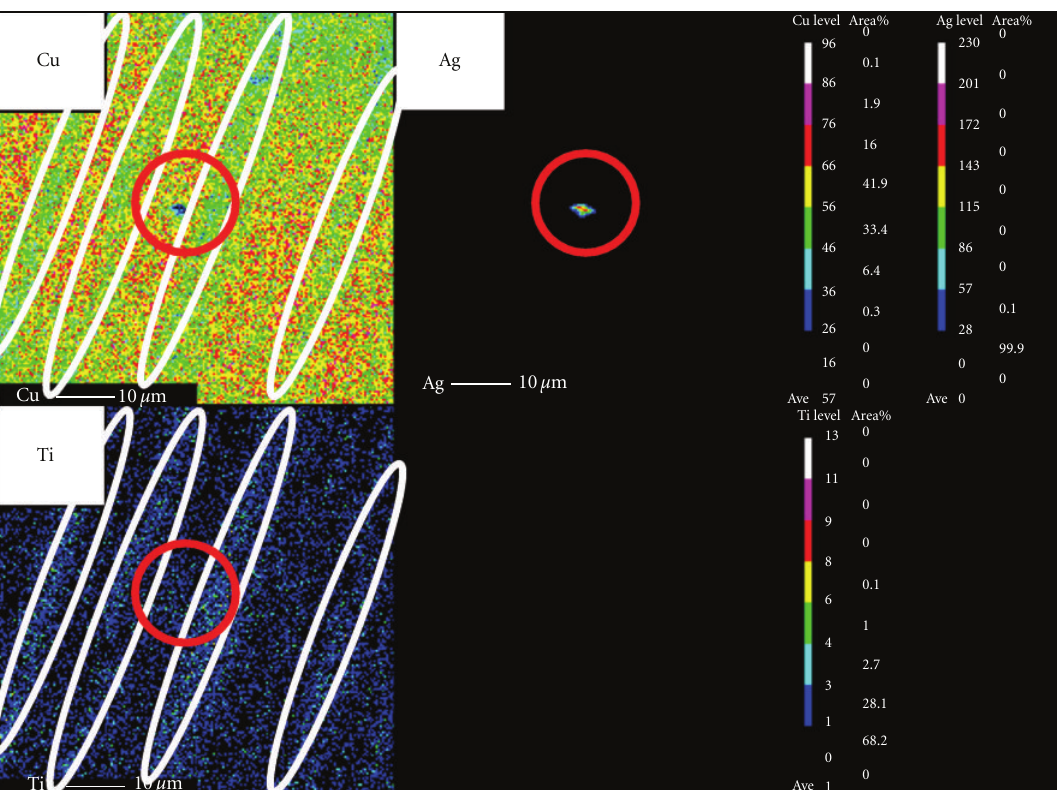
Figure 7: EPMA image of Ag-doped TiO 2 film prepared under the condition of R = 1wt%.